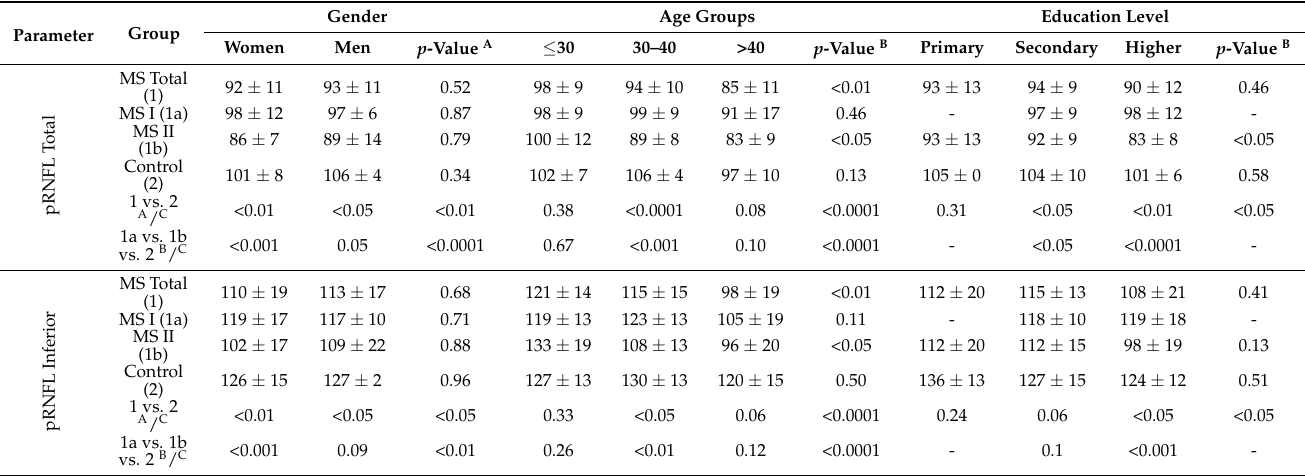
Table 6. Differences in OCT parameters due to gender, age, and education